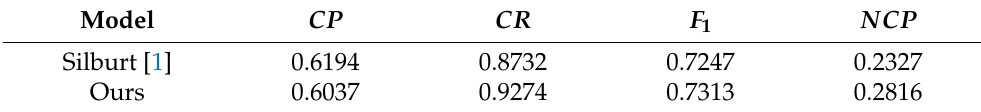
Table 3. Accuracy metrics on our test dataset. Crater-level Precision ( CP ), Crater-level Recall ( CR ), Crater-level F 1 score ( CF 1 ) and new crater percentage ( NCP ) are